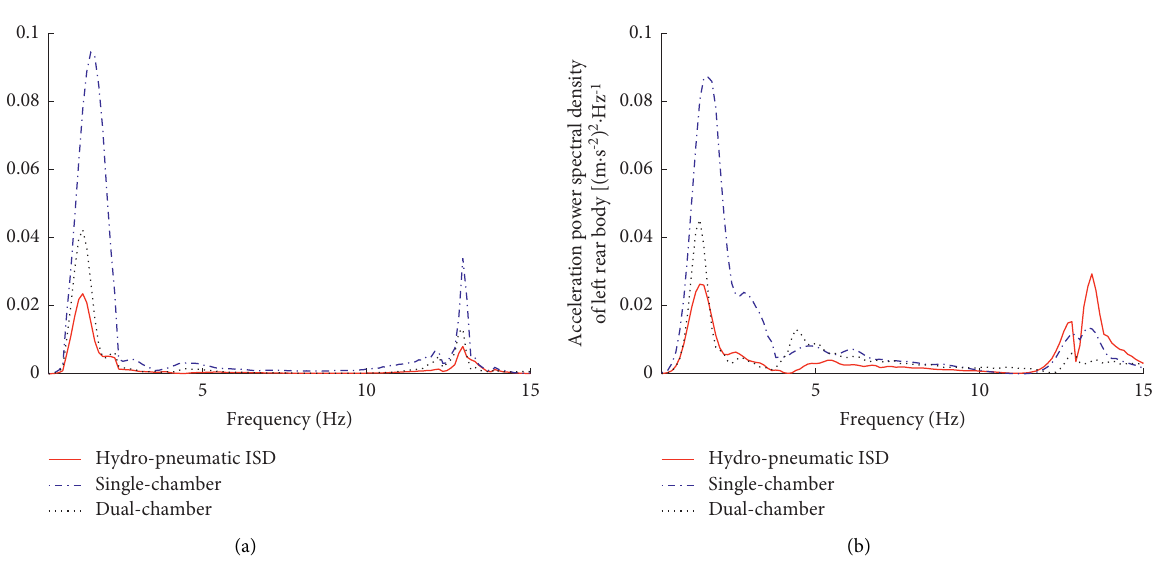
Figure 11: Comparison of natural frequency test results.